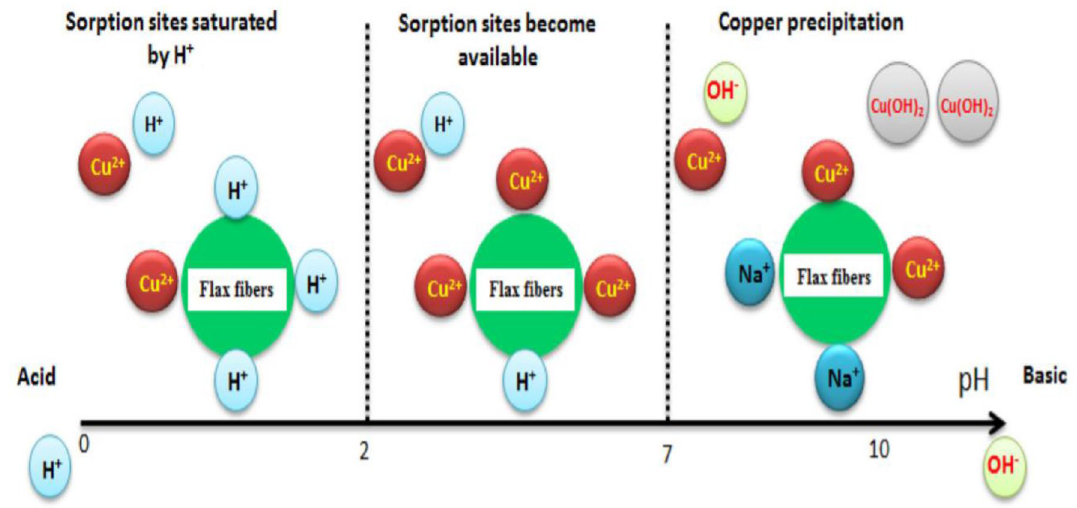
Fig. 8 Effect of pH on the adsorption of heavy metals created based on research by Abbar et al.